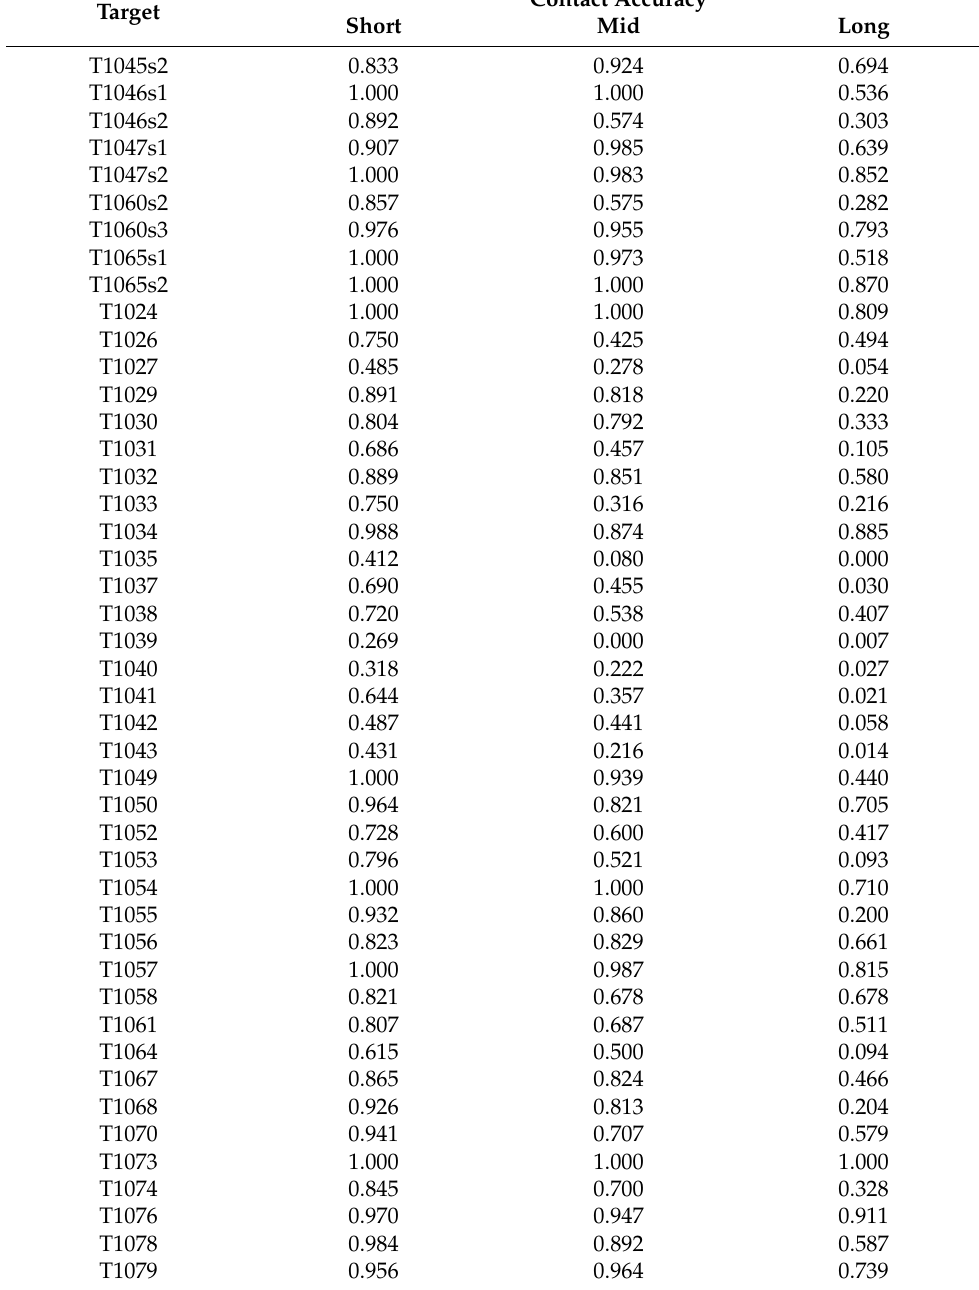
Table 2. ProSPr ensemble contact accuracies (see text for